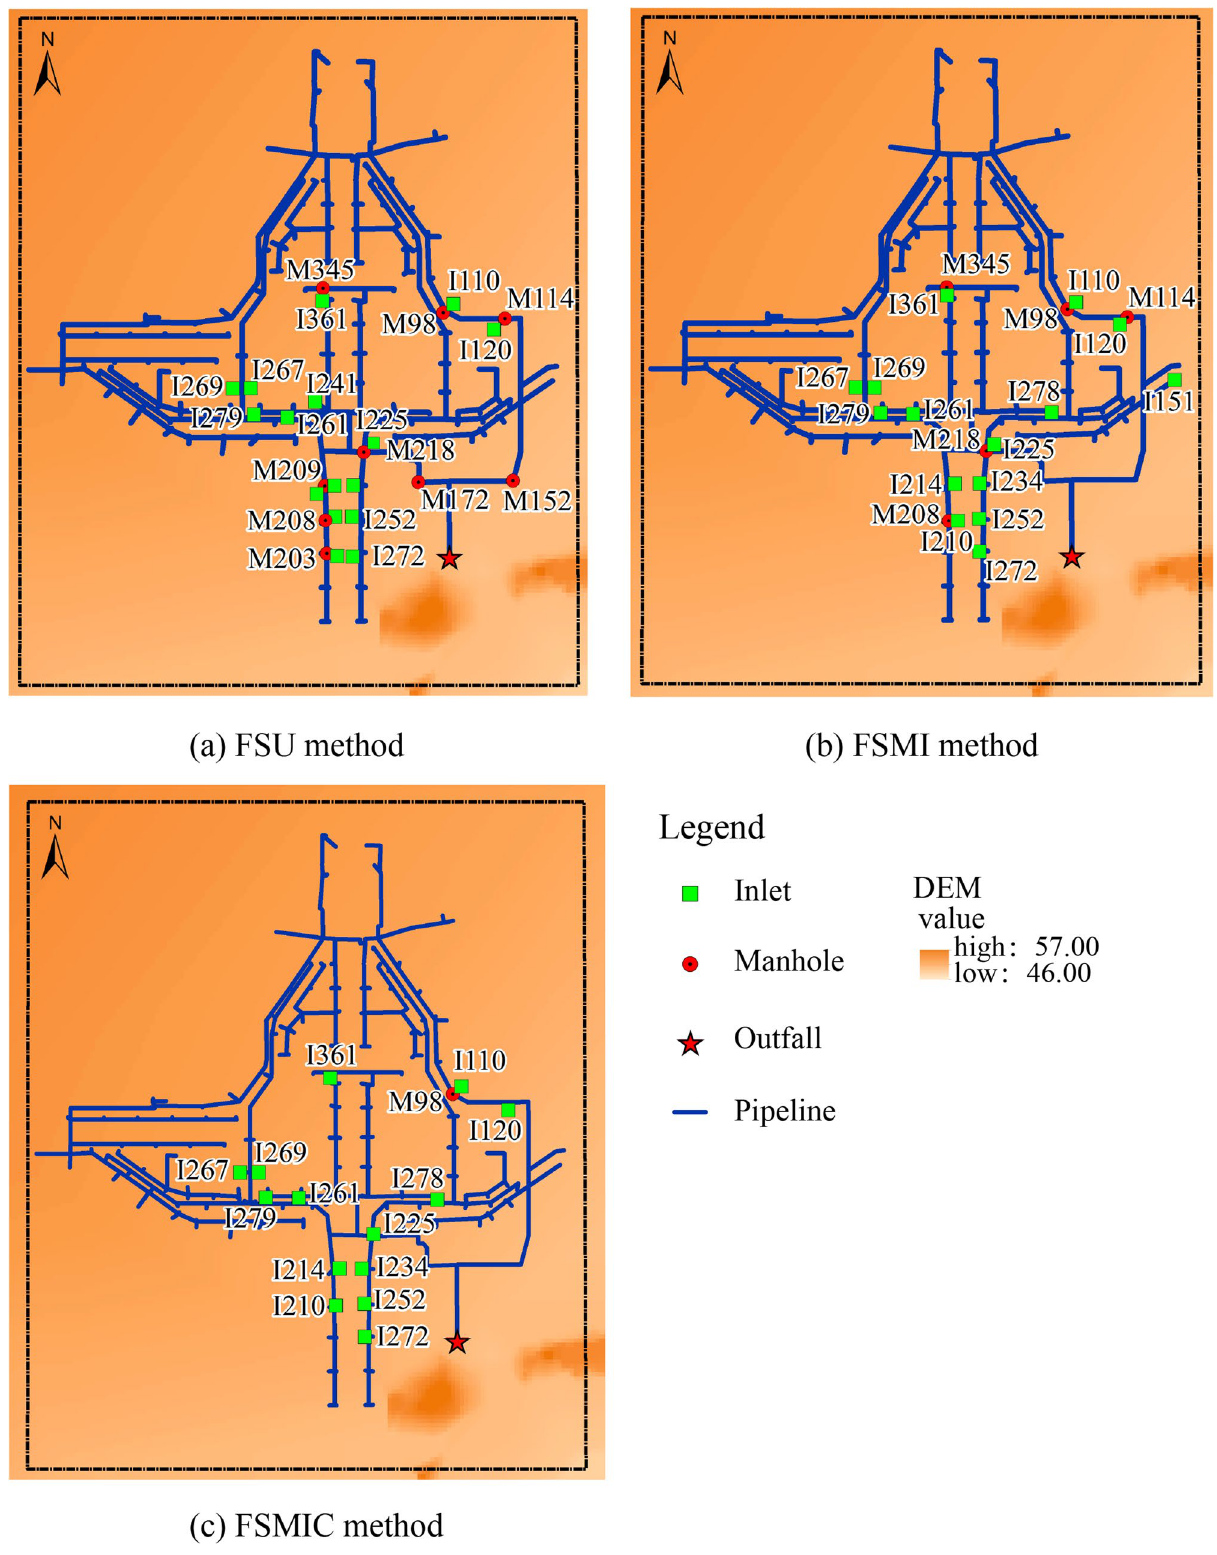
Figure 11. Overflowed nodes for the FS